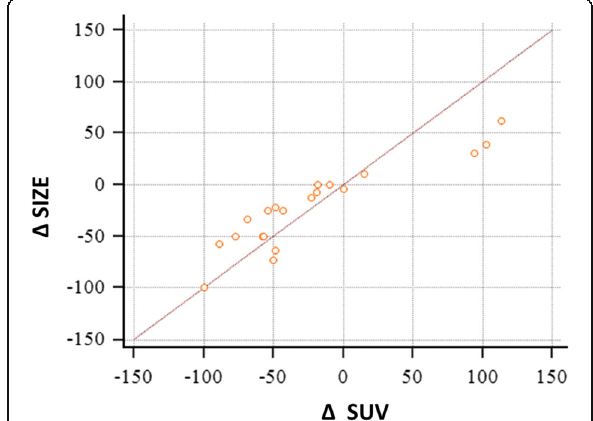
Fig. 6 Scatter diagram displaying the strong positive correlation between Δ SUV and Δ SIZE in all